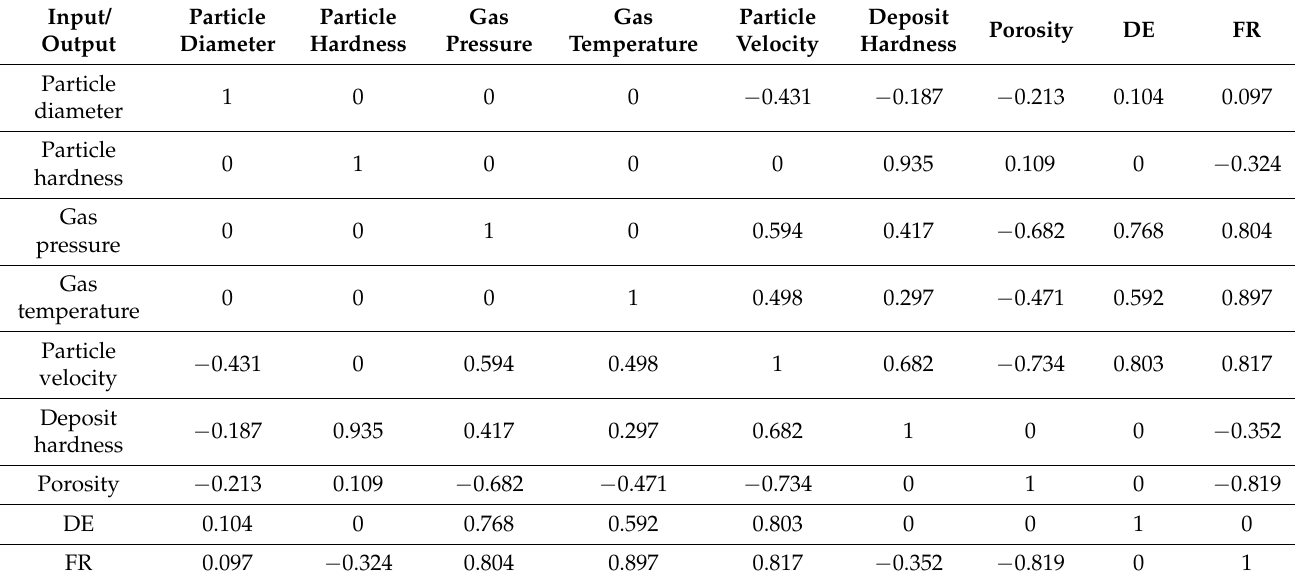
Table 2. Correlation behavior among the different input/output for CS